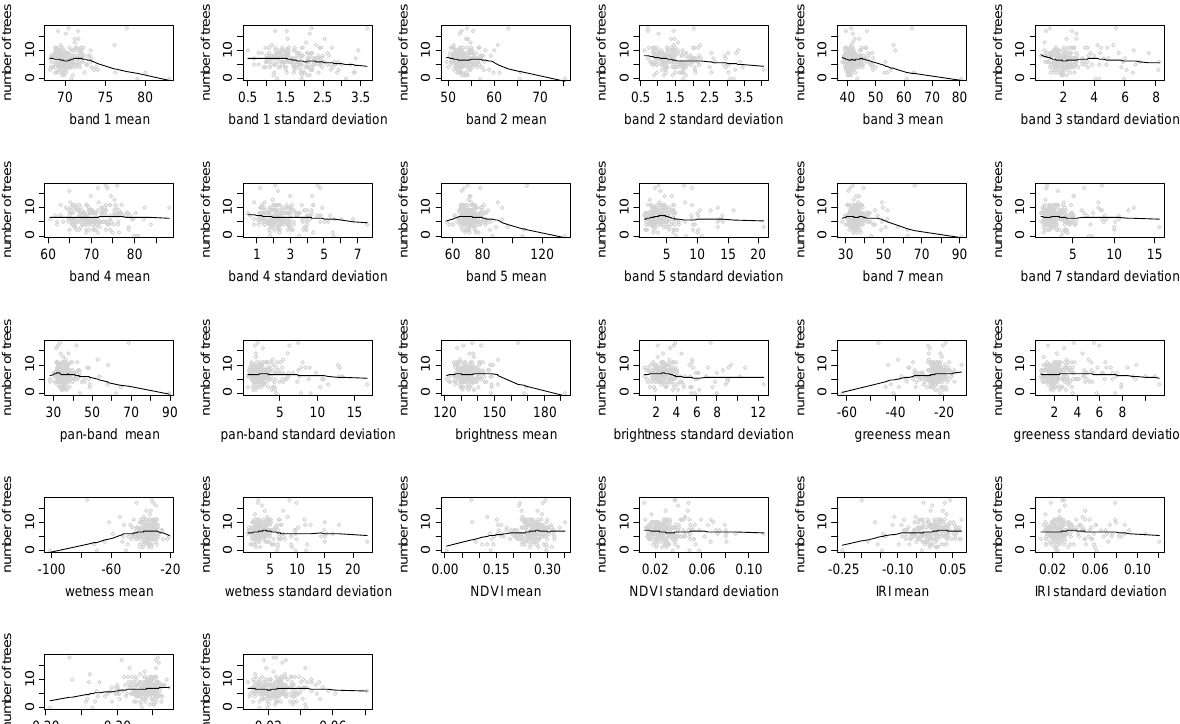
Figure 5. Scatterplots of the number of trees vs. Landsat ETM+ spectral variables Fitted curves represent LOWESS based